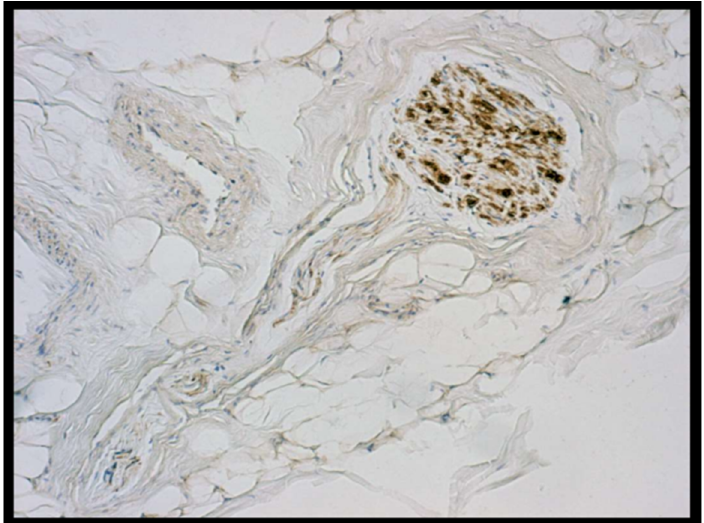
Figure 3. Haematoxylin and antibody anti-S100 colouration. Medial retinaculum section, a Ruffini’s corpuscle (10×).